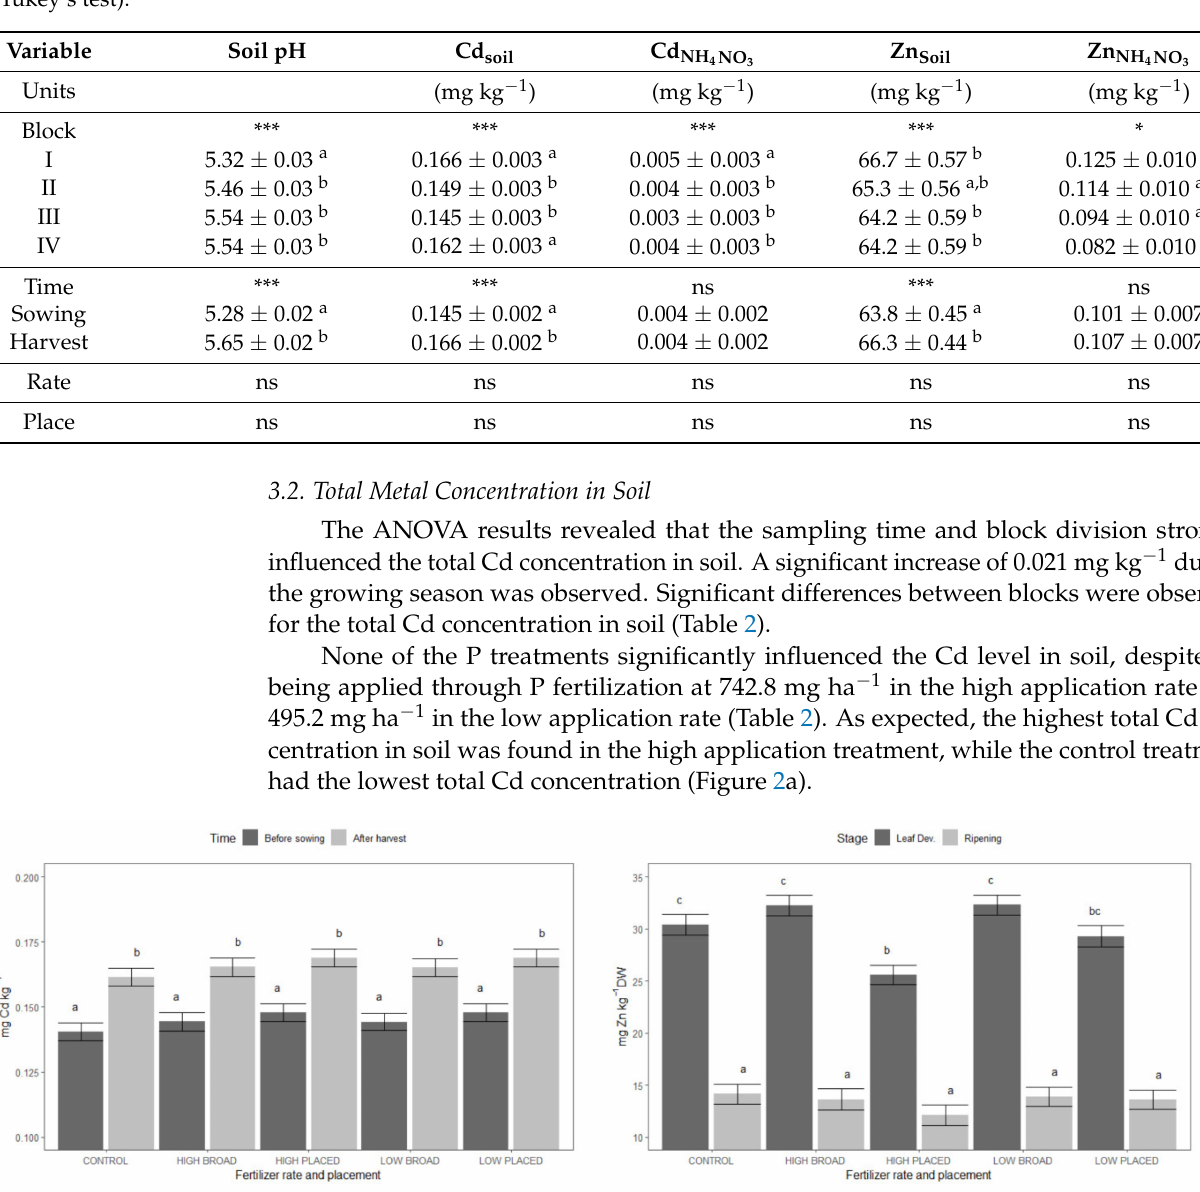
Table 2. Significant effect of field variables on the concentrations of Cd and Zn in soil and silage maize ( n = 80). Significance levels for p -value: ***, p < 0.001; *, p < 0.05; ns, p ≥ 0.05. Different letters indicate significant differences at the p < 0.05 level (Tukey’s test).